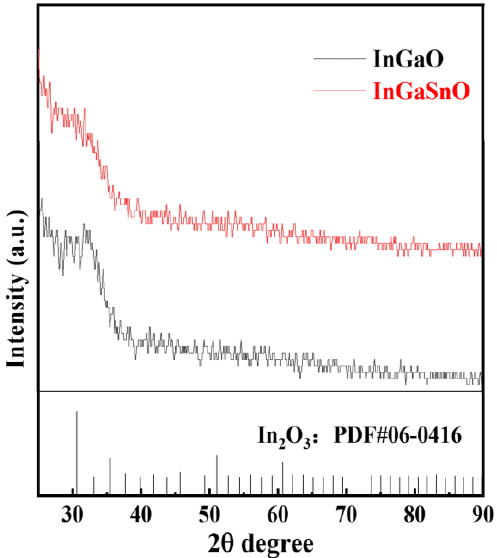
Figure 3. XRD spectra of the InGaO and InGaSnO films annealed at 350 ◦ C for 1 h.